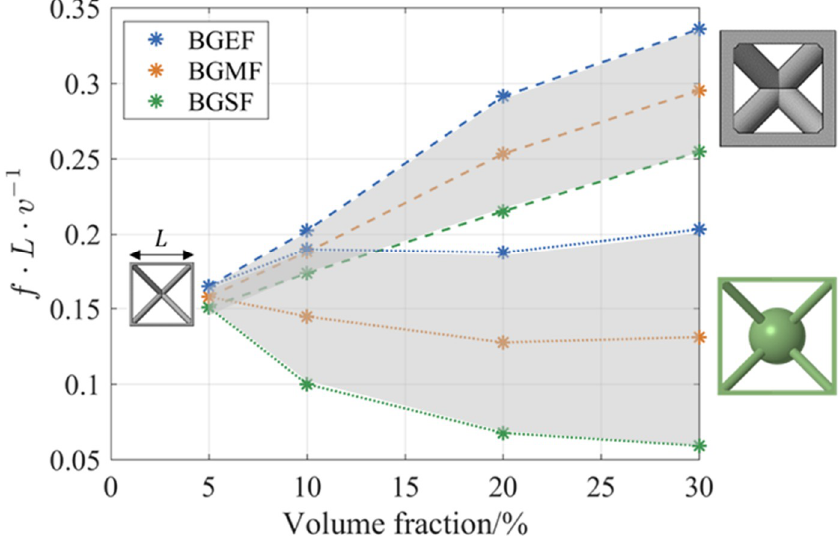
Figure 12. Attributes of the BGs as identified from the DCs of the BCC xyz (dashed lines) and res-BCC xyz (dotted lines) lattices at different volume fractions.